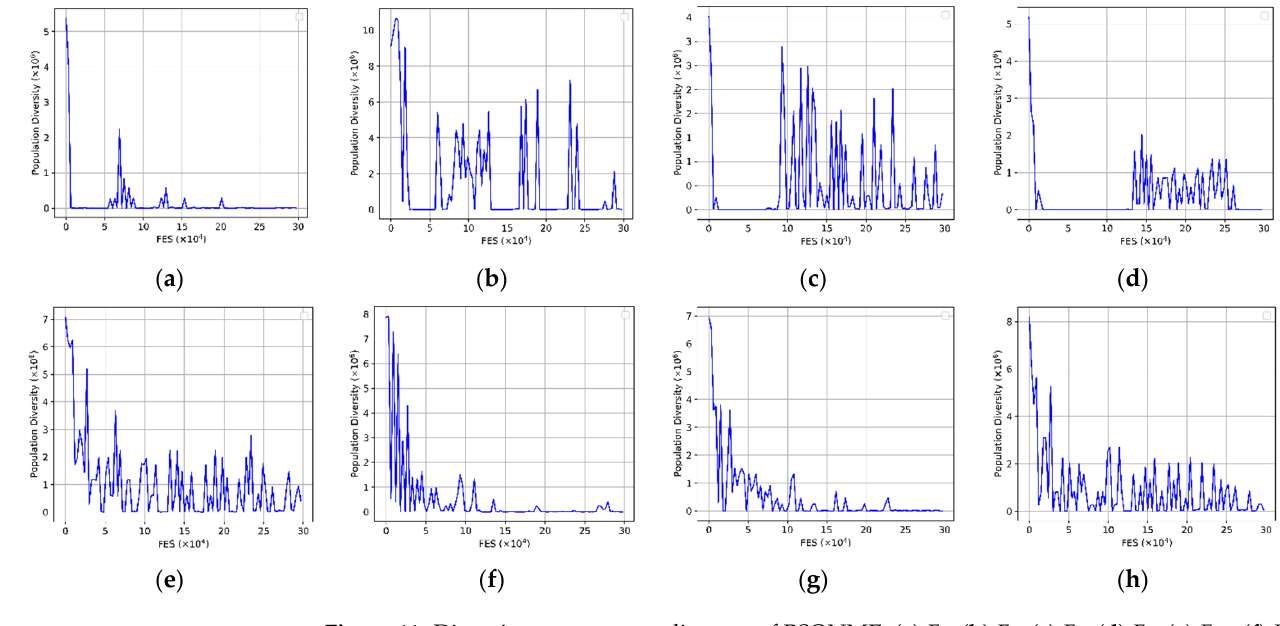
Figure 11. Diversity convergence diagram of BSONME. ( a ) F 2 ; ( b ) F 5 ; ( c ) F 7 ; ( d ) F 9 ; ( e ) F 13 ; ( f ) F 17 ; ( g ) F 22 ; ( h ) F 26 .